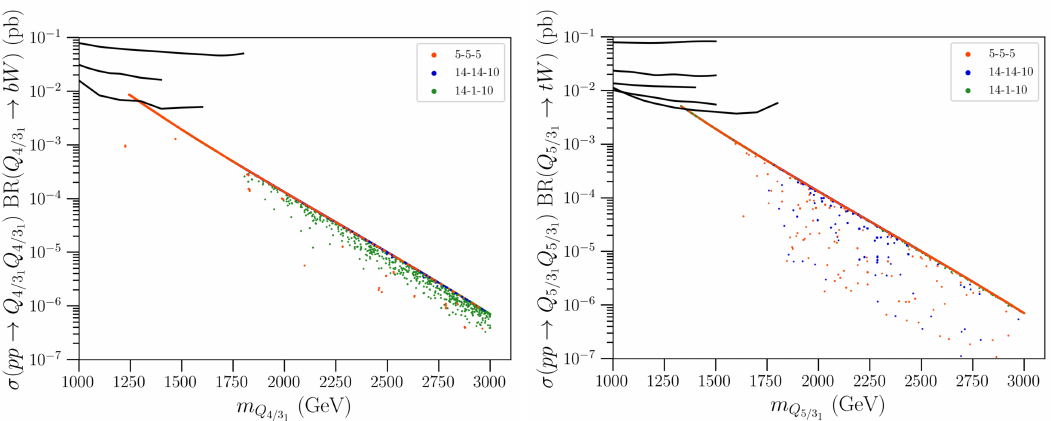
Figure 13. Cross sections for decays of the lightest resonances Q x with exotic electric charge x √ into SM final states at s = 13 TeV for valid points in each model. Most of the points in each model lie on the prominent lines in these plots. Black lines mark the 95 % CL upper bounds taken as constraints.